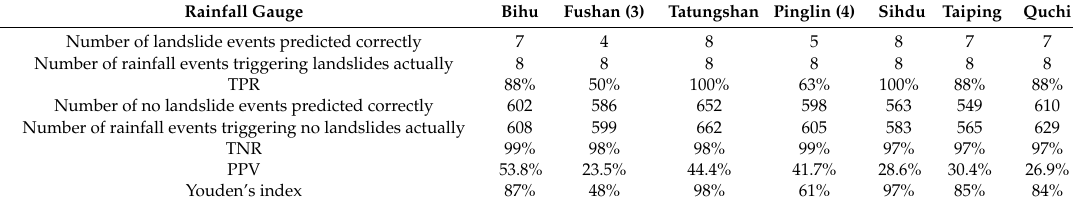
Table 3. TPR, TNR, PPV, and Youden’s index for all rain gauges at a rainfall probability threshold of